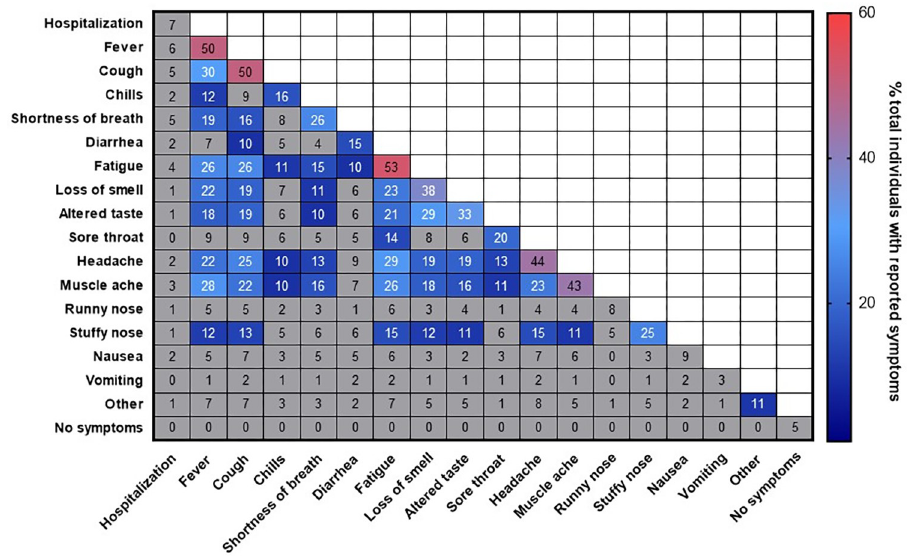
Fig 1. Frequency and correlation of COVID-19 symptoms. Percentage of individuals with the symptoms or pairs of symptoms are presented. Symptom or symptom pairs prevalent in > 10% of individuals are colored.